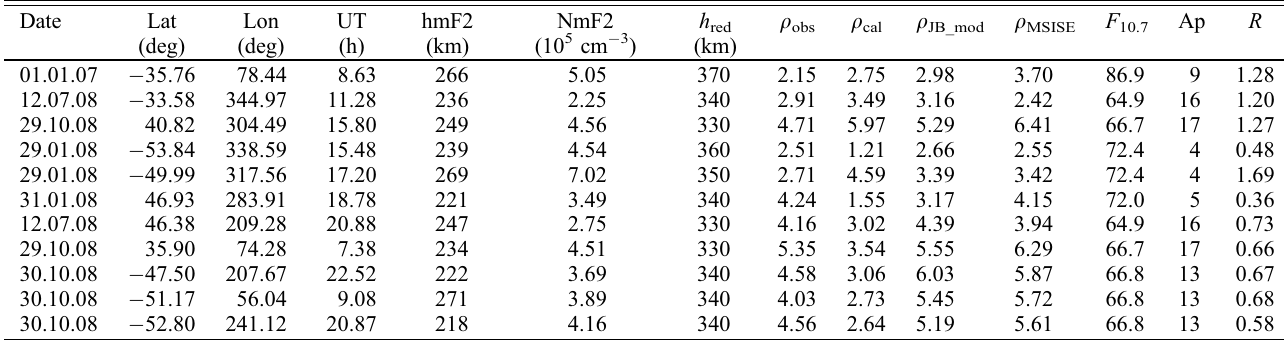
Table A2. Same as Table A1 but for the RO EDP which formally provide the solution resulting in neutral gas densities which are outside